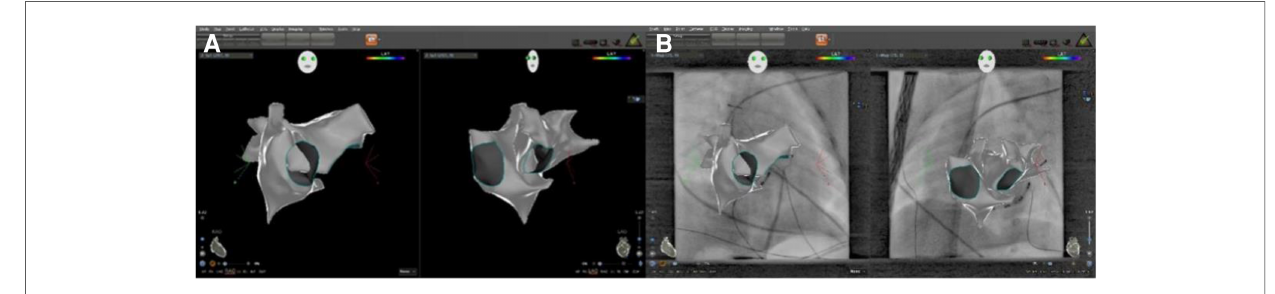
FIGURE 1 The cardiac 3D model images of CARTO3 and CARTO univu. Slide ( A ) shows the CARTO3 cardiac 3D model image with a right anterior oblique position of 30° and a left anterior oblique position of 45° on a black background; Slide ( B ) shows the CARTO Univu model, which puts the prerecorded x-ray cardiac image into the CARTO3 system and allows mapping and ablation on the background of x-ray cardiac